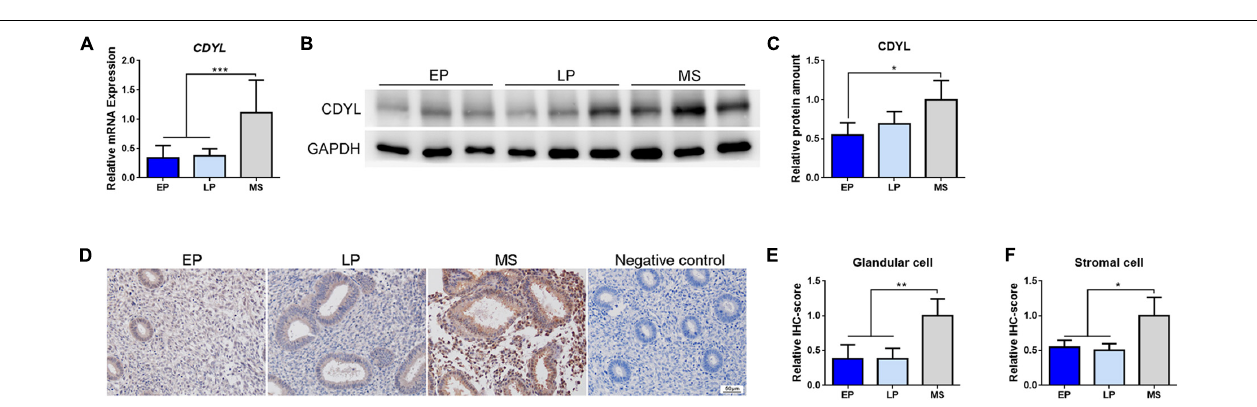
FIGURE 2 | The expression of CDYL was increased in the endometrium during the menstrual cycle. (A) RT-qPCR, (B) Western blot analysis, and (C) densitometric quantification of CDYL expression in endometrium during the menstrual cycle. EP, early proliferative phase, n = 8; LP, late proliferative phase, n = 12; MS, mid-secretory phase, n = 22. (D) Immunohistochemistry staining and (E,F) semi-quantification of CDYL protein expression in endometrial cells during the normal menstrual cycle. EP, n = 5; LP, n = 5; MS, n = 5. All data are presented as mean ± SD. * P < 0.05; ** P < 0.01; *** P <